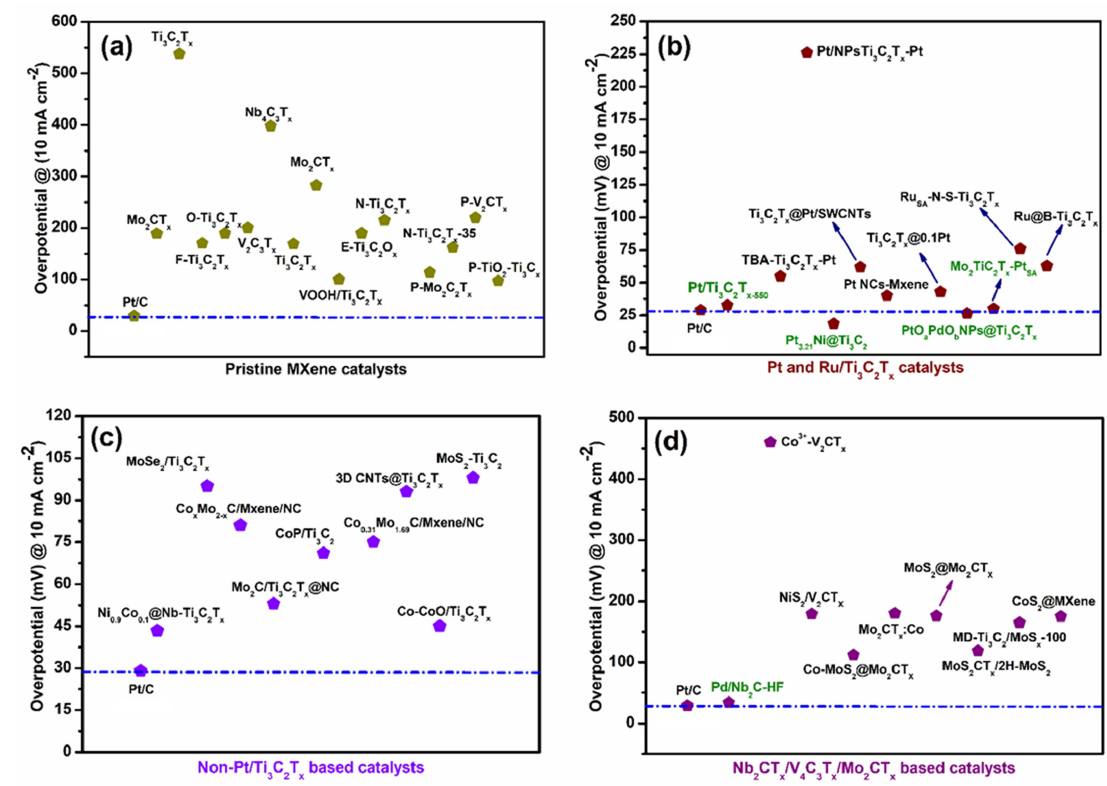
Figure 13. Benchmark figure ( a ) pristine MXene ( b ) Pt-supported Ti 3 C 2 T x ( c ) non-precious metal supported Ti 3 C 2 T x ( d ) Pt and non-precious metal supported on other types of MXenes, other than Ti 3 C 2 T x showing the overpotential status of various MXene-based catalysts with respect to standard Pt/C (for overpotential values of the catalysts, refer to Table 2. The Pt/C reference values were taken from Ref. [102]). Table 2. Summary of electrochemical performance of MXene-supported catalysts for HER. Overpotential (mV) @ Catalyst 10 mA cm 2